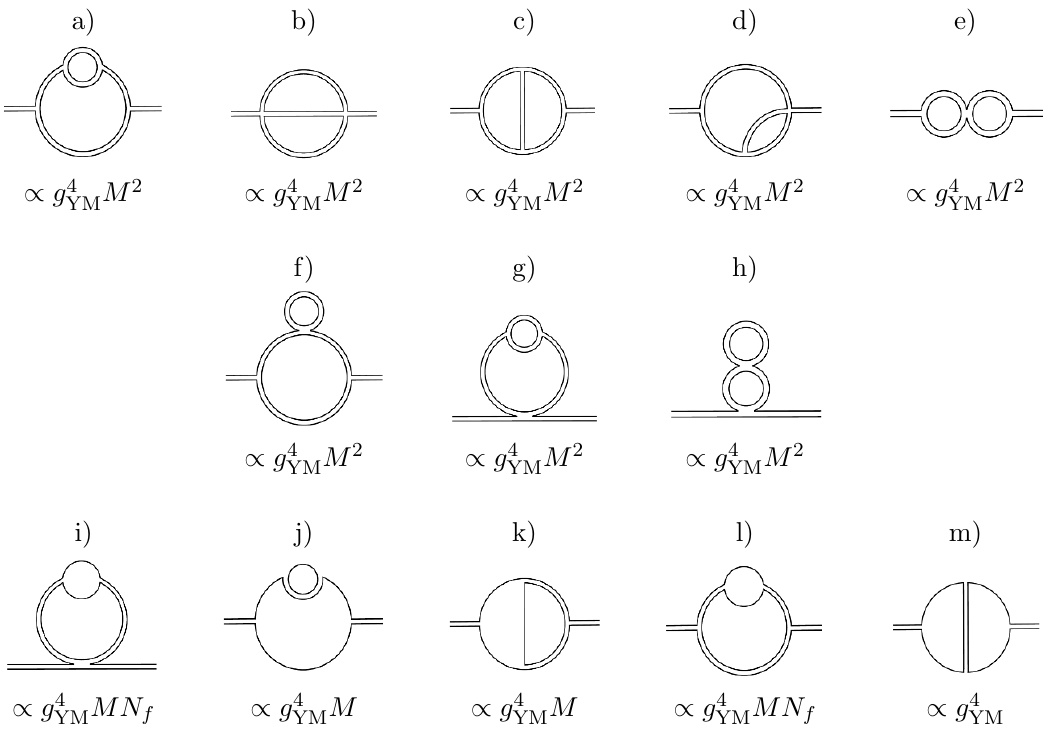
Figure 4 . 2-loop diagrams contributing to the gauge boson self-energy with their relative sizes. Diagrams a){g) | purely gluonic contributions; h){j) | contributions with fermionic degrees of